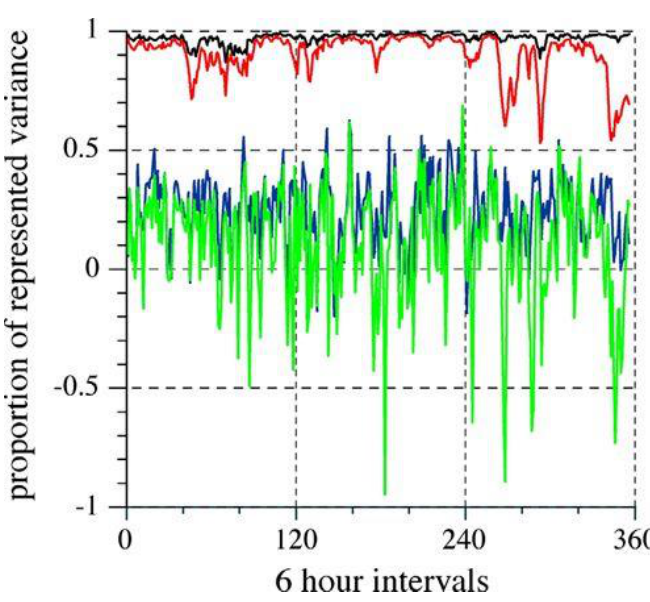
Figure 1. Similarity of zonal wind at 850 hPa between simulations and (driving) NCEP/NCAR reanalyses in constrained (black and blue) and unconstrained (red and green) simulations with a limited area model. Top: Large spatial scales. Bottom: Regional spatial scales. [13], © Copyright 2000 AMS.